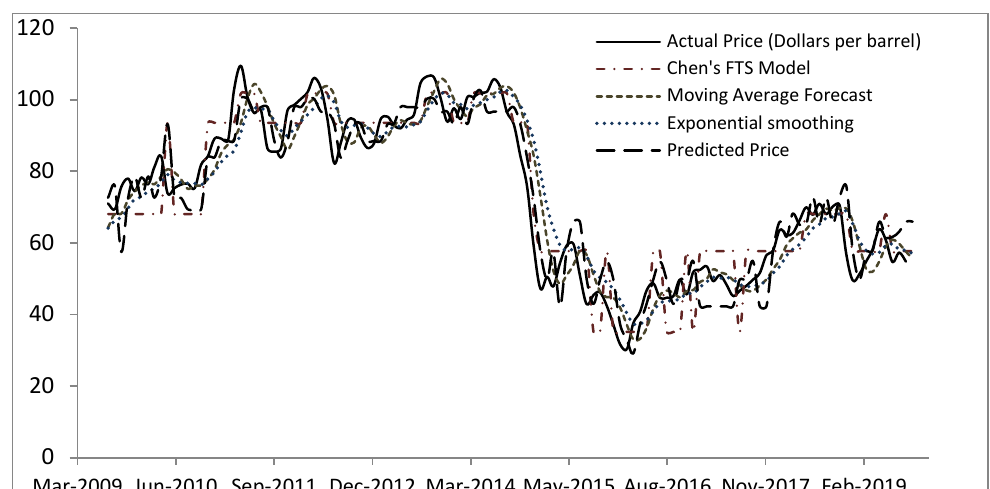
Figure 1. Graphical representation of testing